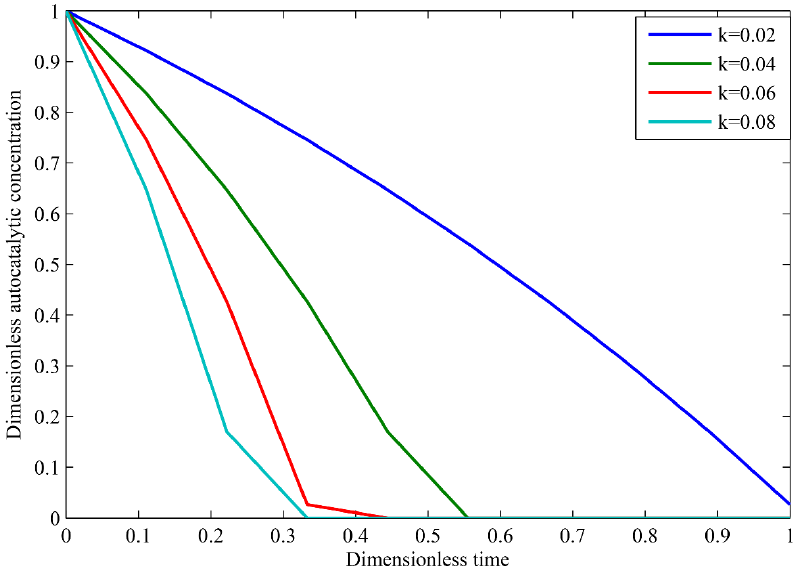
Figure 5. Dimensionless autocatalytic concentration versus dimensionless time for reactions.